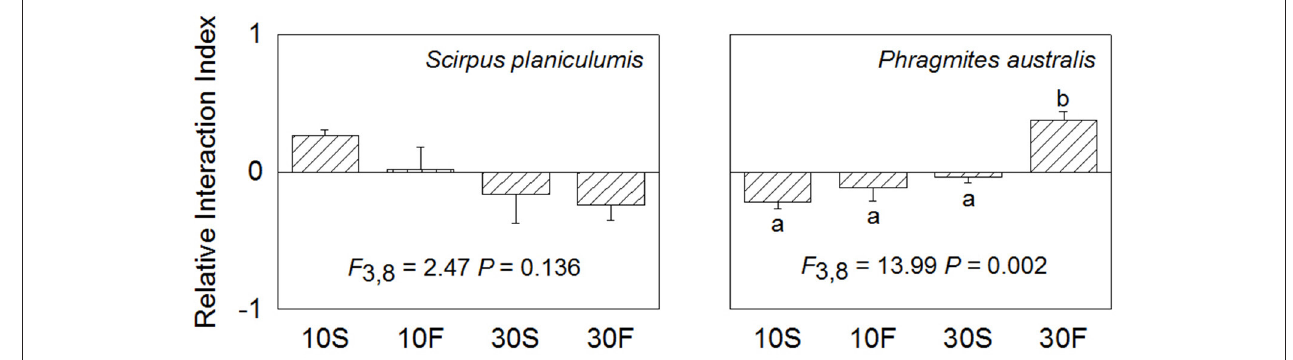
FIGURE 4 | Relative interaction index (RII) of Scirpus planiculumis and Phragmites australis in monoculture or mixed culture under four hydrological conditions. Shown are means ± SE. Different letters indicate a significant difference among treatments (one-way ANOVA followed by Dunnett’s